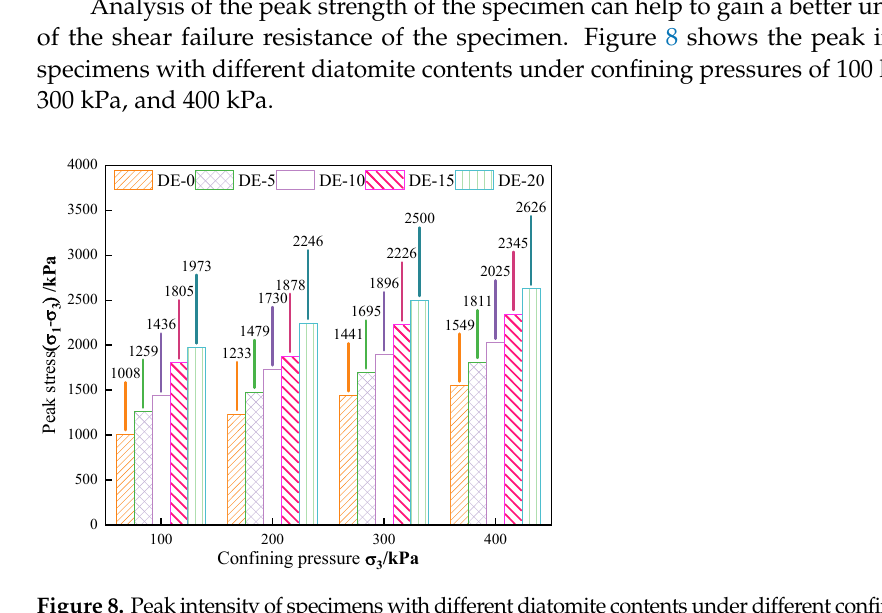
Figure 8. Peak intensity of specimens with different diatomite contents under different confining pressures.